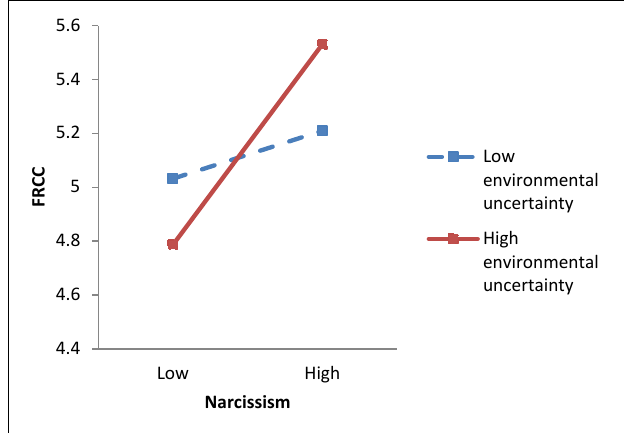
FIGURE 2 | Study 1 moderating effect of environmental uncertainty on the relationship between narcissism and felt responsibility for constructive